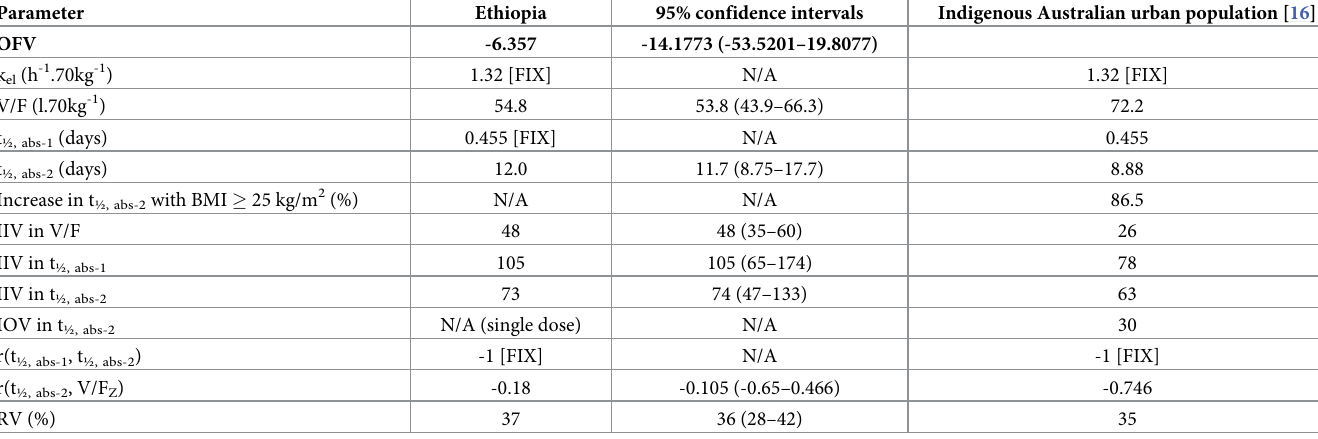
Table 1. Parameterized final population pharmacokinetic estimates for structural model parameters for Ethiopian patients receiving benzathine penicillin G. Comparable parameter estimates for a similar structural model in Indigenous Australians are provided